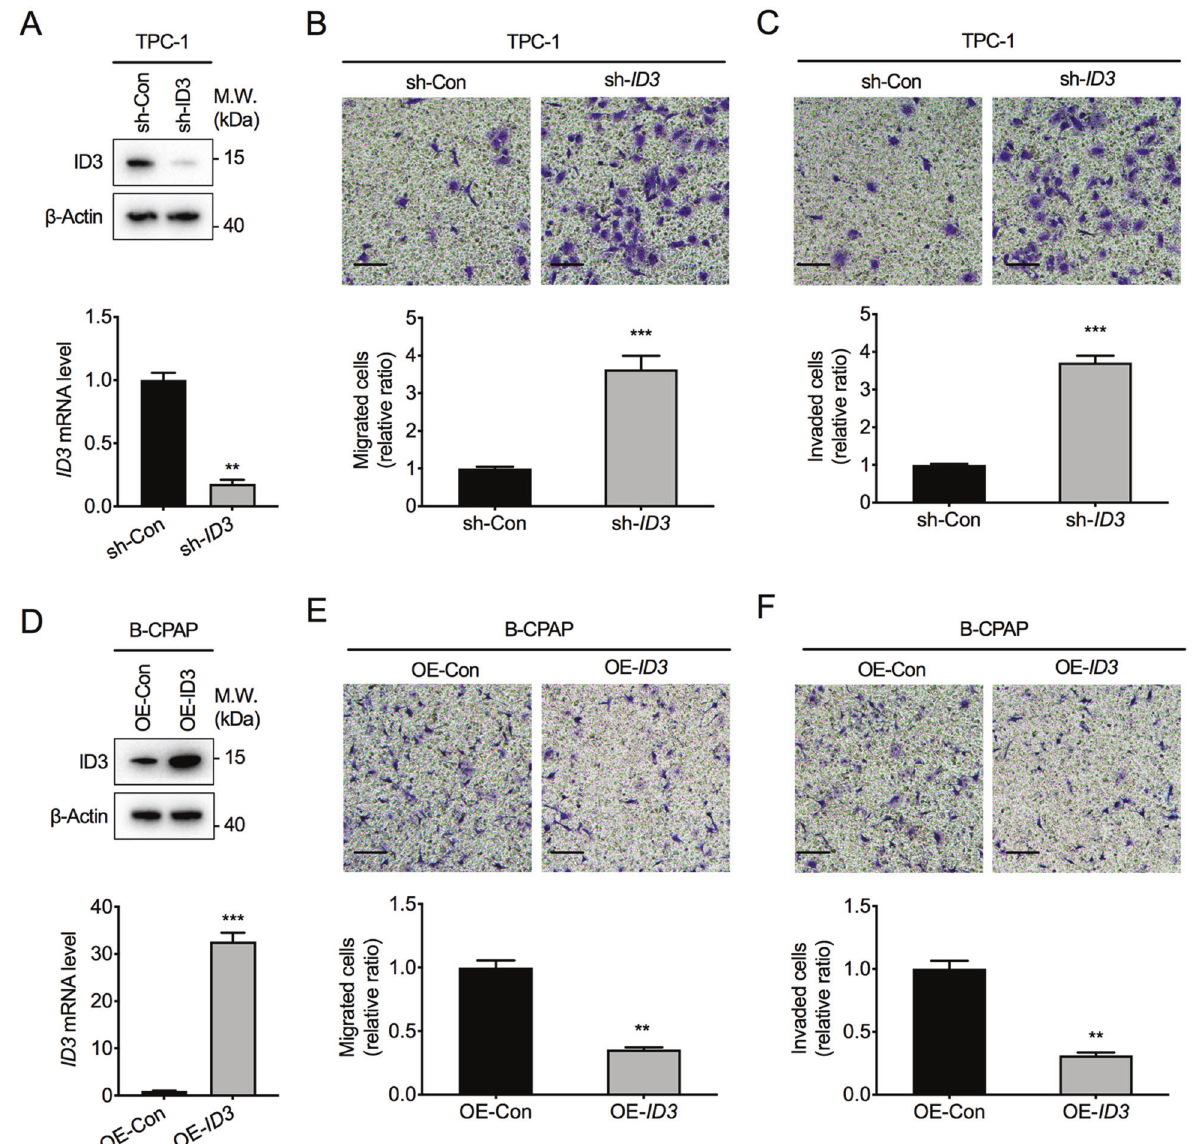
Fig. 3 ID3 inhibits PTC cells migration and invasion. A ID3 protein and mRNA levels in TPC-1 cells stably transfected with ID3 shRNA (sh-ID3) or control shRNA (sh-Con). ** P < 0.01. B , C Representative images (top) and relative bar graphs (bottom) depicting the relative cell migration rate ( B ) and invasion ( C ) rate normalized to control group in TPC-1 cells. Bar, SD. *** P < 0.001. Scale bars = 200 μ m. D ID3 protein and mRNA levels in B-CPAP cells stably transfected with ID3 overexpression (OE-ID3) or control lentiviruses (OE-Con). *** P < 0.001. E , F Representative images (top) and relative bar graphs (bottom) depicting the relative cell migration ( E ) and invasion ( F ) rate normalized to control group in B-CPAP cells. Bar, SD. ** P < 0.01. Scale bars = 200 μ